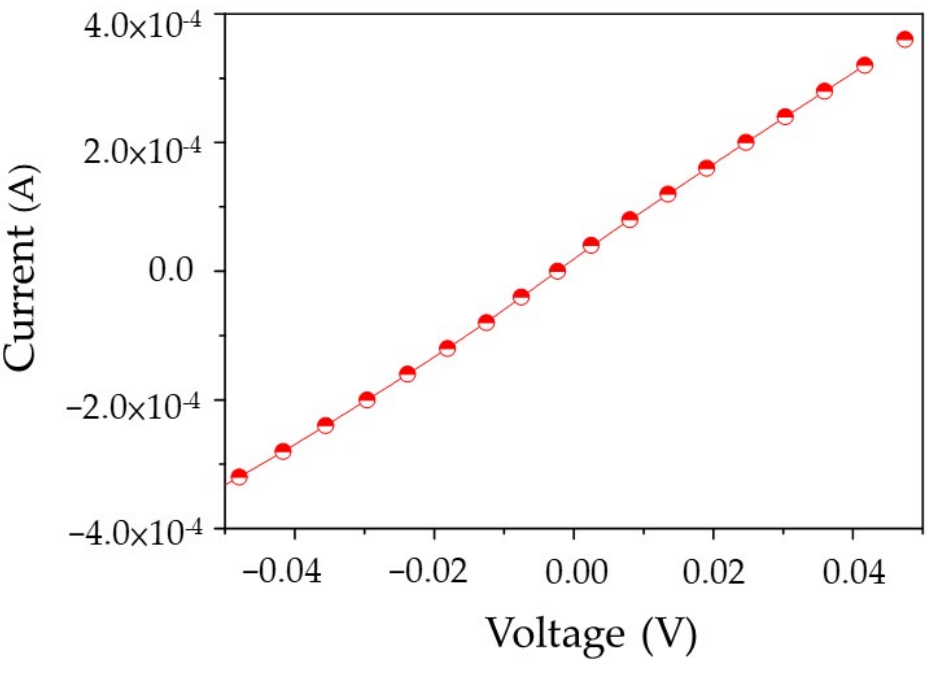
Figure 6. The I-V curve for the Hall measurement.